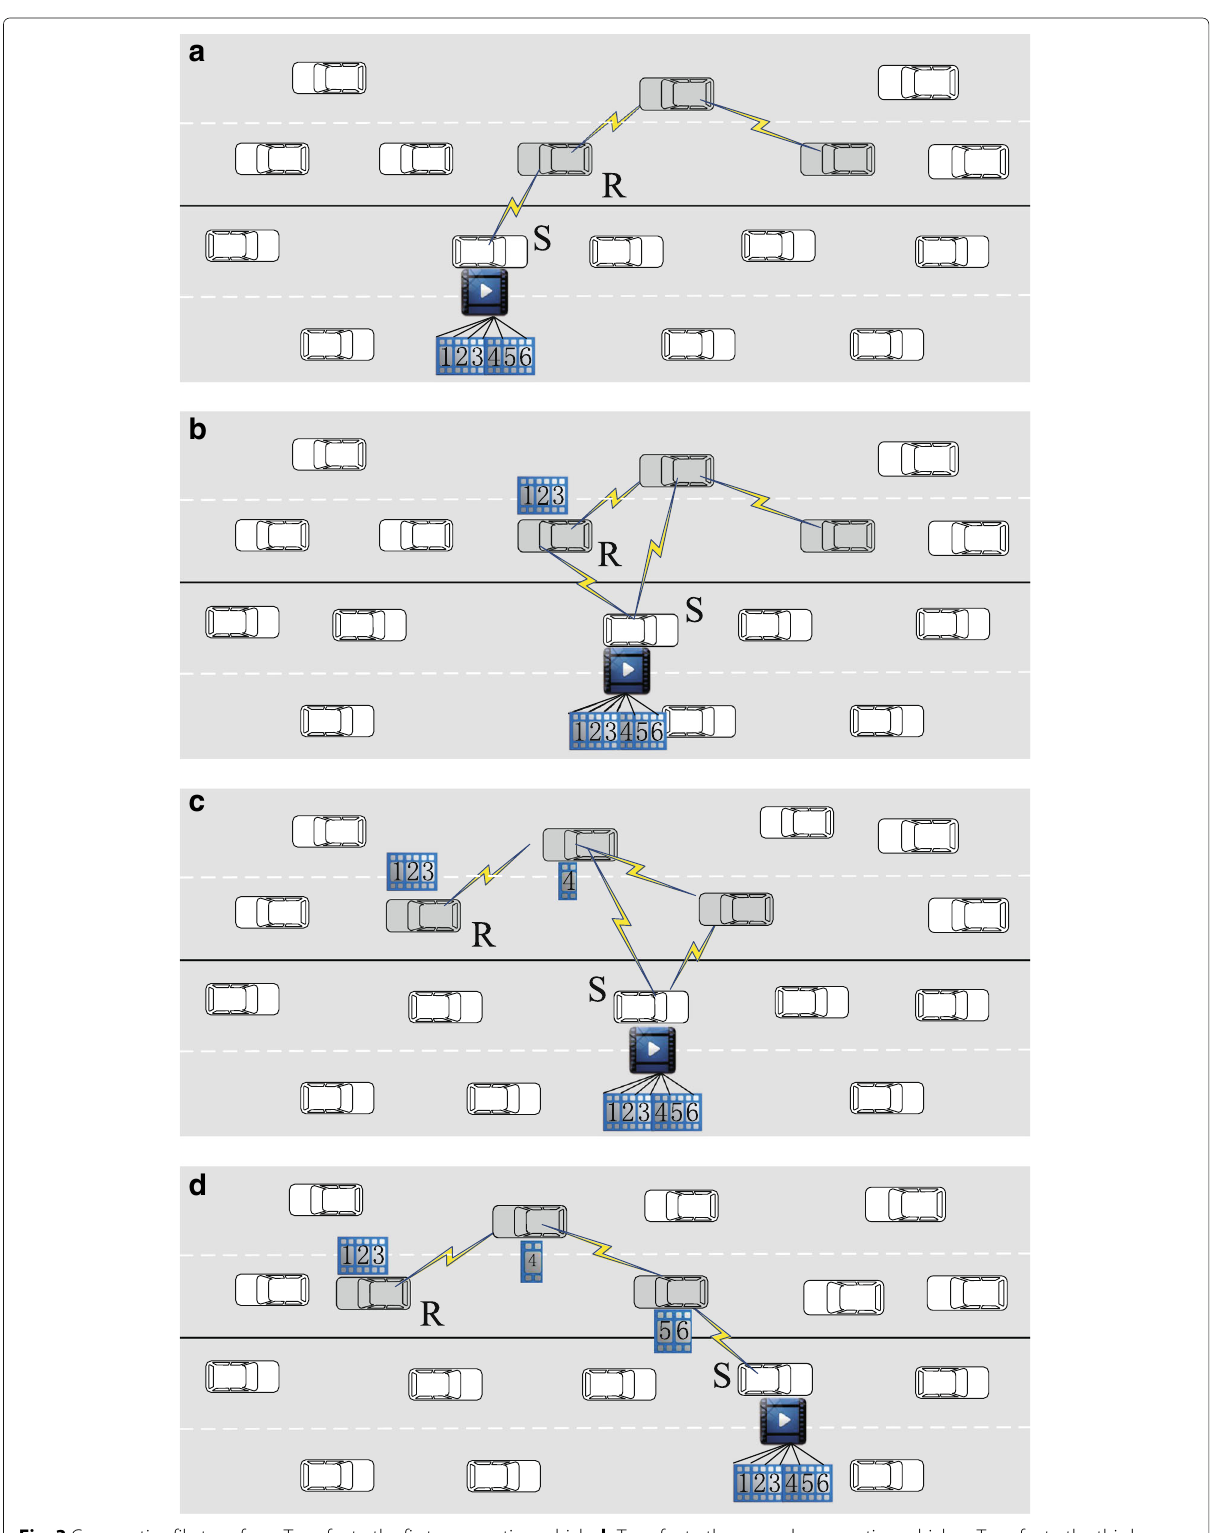
Fig. 3 Cooperative file transfer. a Transfer to the first cooperative vehicle, b Transfer to the second cooperative vehicle, c Transfer to the third cooperative vehicle and d Transfer to cooperative vehicles